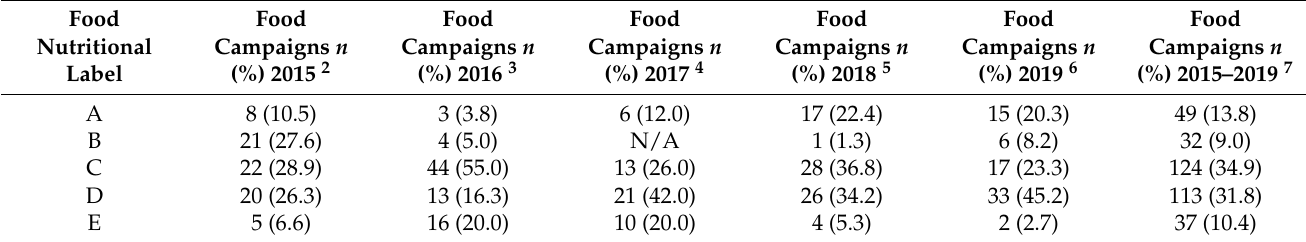
Table 1. Nutri-score 1 classification of the advertised breakfast products campaigns by year.